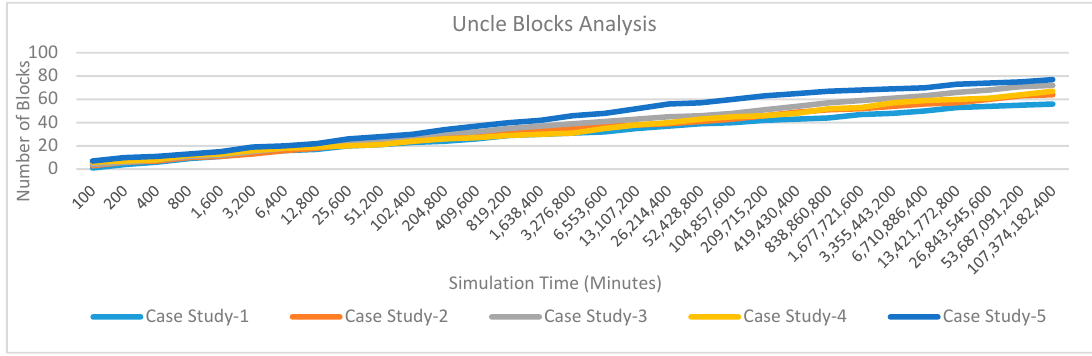
Figure 27. Comparative uncle block analysis.